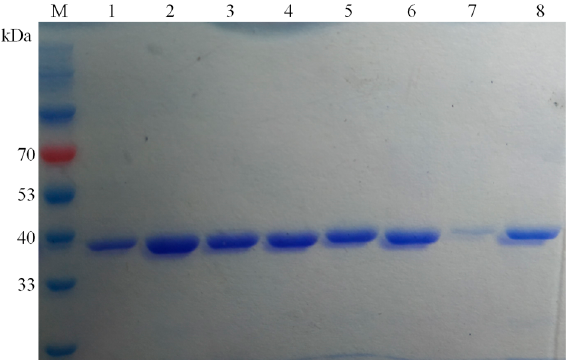
Figure 1. SDS-PAGE analysis of DLFae4 and variants. lane 1, purified DLFae4 protein; lane 2, puri- purified variant DLFae4-m1 protein; lane 3, purified variant DLFae4-m2 protein; lane 4,